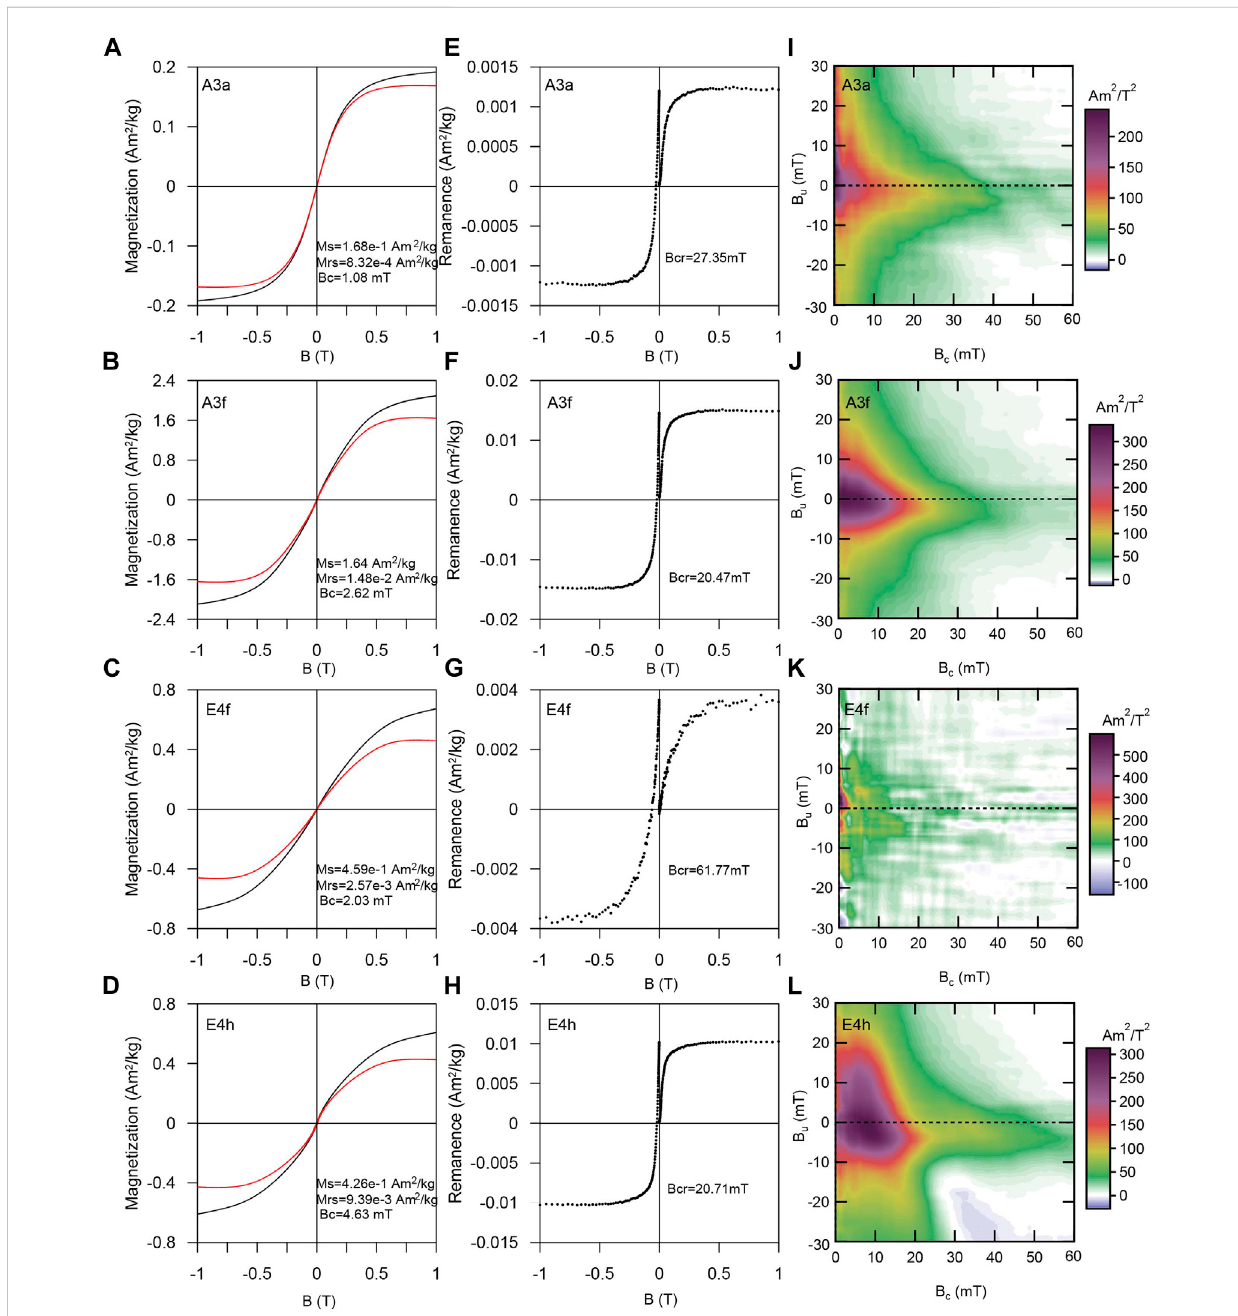
FIGURE 11 (A – D) Representative hysteresis loops of NWA13788. Black and red lines are loops before and after high- fi eld slope correction. (E – H) Isothermal remanent magnetization (IRM) acquisition and back- fi eld demagnetization curves. (I – L) Representative FORC diagrams. Data were processed using the FORCinel software version 3.08 (Harrison and Feinberg, 2008). A smoothing factor of 10 was used for the central